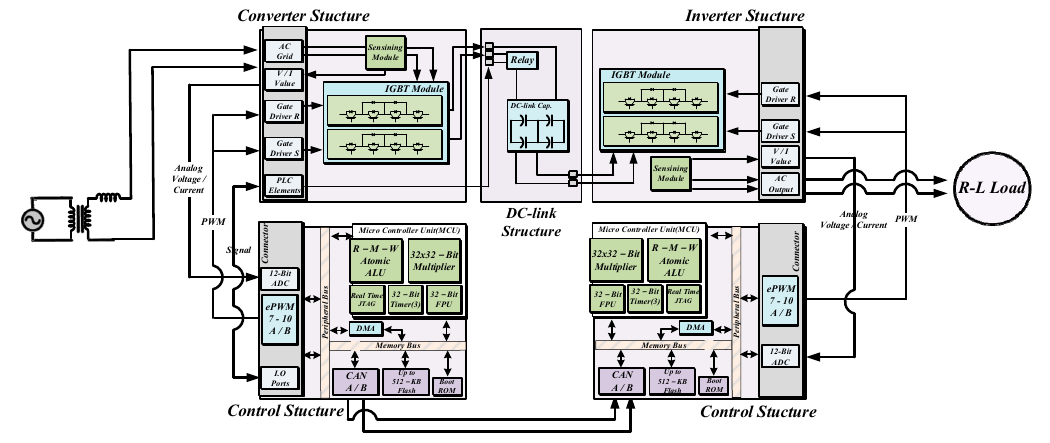
Figure 22. Configuration of the experiment system. Electronics 2018 , 7 , x FOR PEER REVIEW